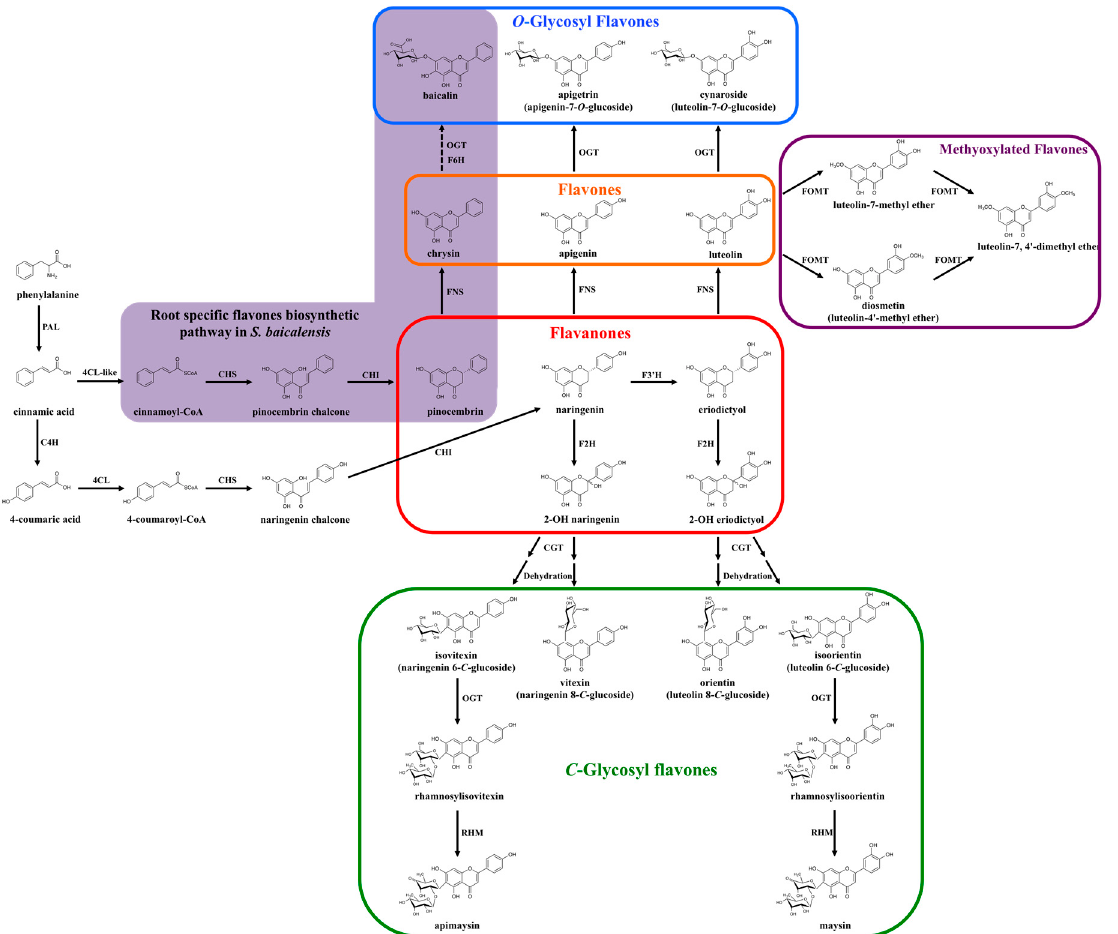
Figure 2. Multiple and specialized flavone biosynthetic pathways. Purple path: Newly identified biosynthetic pathway for root-specific flavones in Scutellaria baicalensis . PAL: phenylalanine